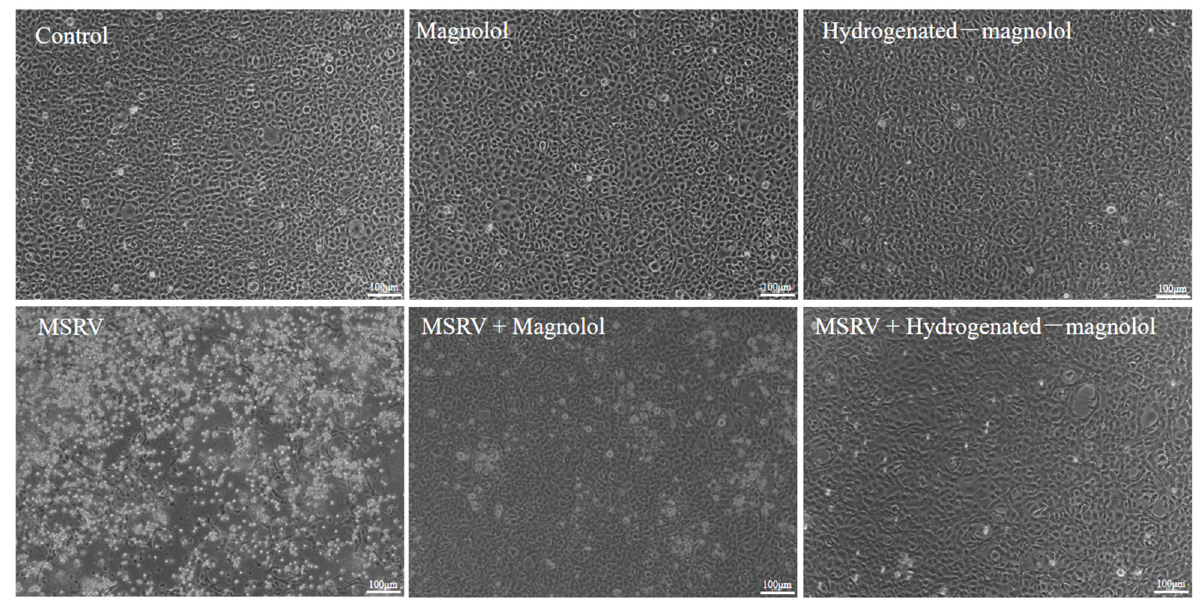
Figure 6. Effects of magnolol and hydrogenated magnolol on CPE induced by MSRV. Hydrogenated magnolol inhibited the CPE phenomenon better than magnolol at the same concentration of 28.89 μ M.